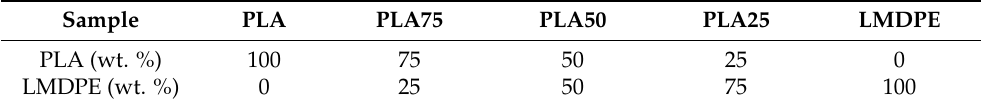
Table 2. Composition of the PLA/LMDPE